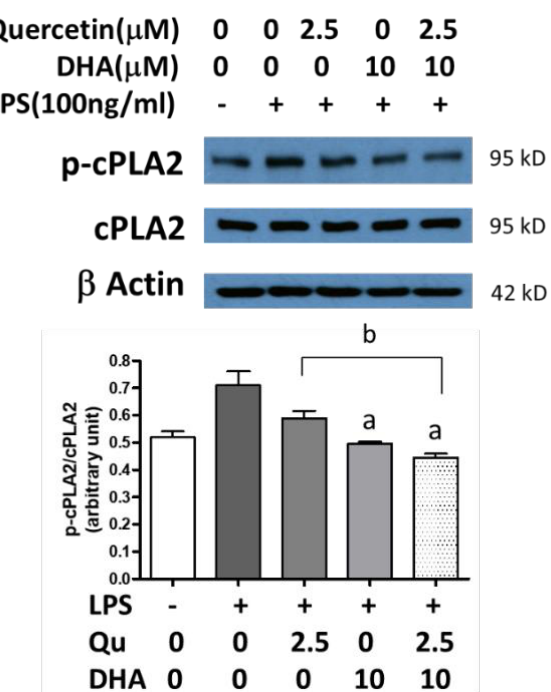
Figure 4. Effects of DHA and/or quercetin on LPS-induced phospho-cytosolic phospholipase A 2 (p-cPLA 2 ) expression in microglial cells. Data represent p-cPLA 2 /cPLA 2 ratios from three individual experiments. “a” represents significant differences ( p < 0.01) between control versus treatments. “b” represents significant differences ( p < 0.05) between the indicated pairs.